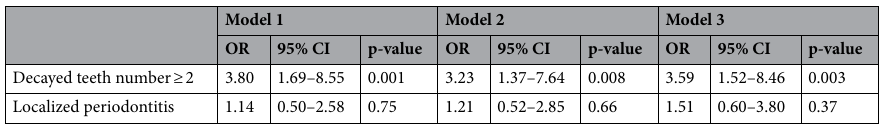
Table 3. Multivariable logistic regression analysis for decayed teeth ≥ 2 and localized severer periodontitis with symptomatic mental stress. Data are presented as odds ratios and 95% confidence intervals (CI) using multiple logistic regression analysis for. Model 1: age, sex and education levels adjustments. Model 2: age, sex, education levels, body weight categories and physical activity adjustments. Model 3: age, sex, education levels, body weight categories, physical activity, high-density lipoprotein, fasting glucose, triglycerides and cigarette smoking